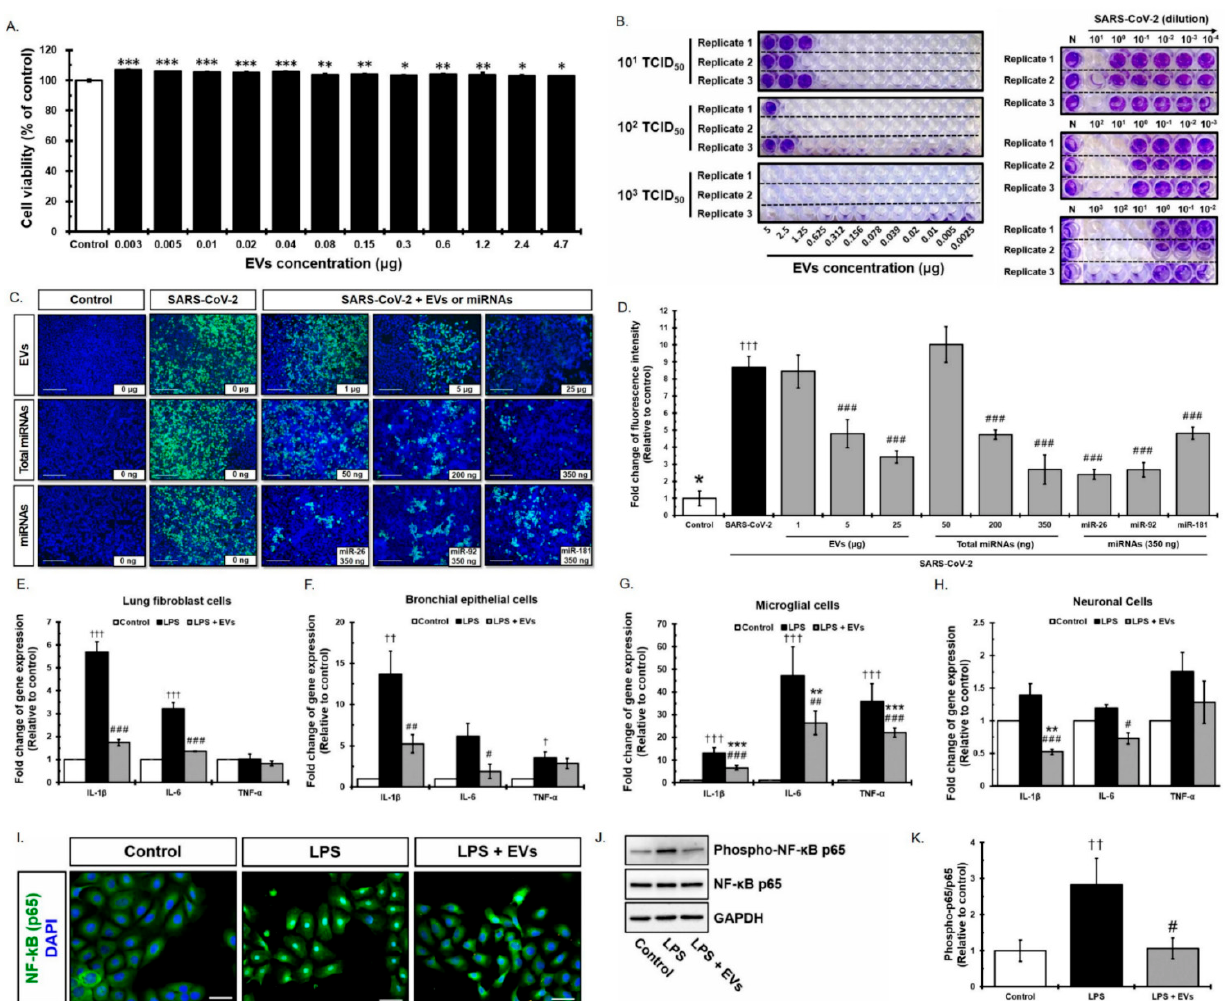
Figure 2. Antiviral effect of placenta-derived EVs against SARS-CoV-2. ( A ) The cytotoxicity of EVs evaluated by using the MTT assay on Vero cells. ( B ) The anti SARS-CoV-2 activity of EVs was tested using an established cell-based screening assay. Vero cells were infected with SARS-CoV-2 virus 10-fold serial dilution: 10 1 TCID 50 /well, 10 2 TCID 50 /well, and 10 3 TCID 50 /well. ( C ) Antiviral effect of placenta-derived EVs, total miRNAs isolated from placenta-derived EVs, and miR-26a-5p, miR-92a-3p, miR-181a-5p against SARS-CoV-2 virus shown in immunofluorescence image. Scale bar: 200 µm. ( D ) Quantification of SARS-CoV-2 infection cells. ( E – H ) Protection effect of EVs on LPS stimulation in lung fibroblast cells (LL24), bronchial epithelial cells (Beas-2B), microglial cells (BV2), and neuronal cells (NSCs). ( I ) Location of NF- κ B p65 after LPS treatment or LPS+EVs treatment. Scale bar: 50 µm. ( J ) Representative expression of NF- κ B p65 and the expression of phospho-p65 after LPS or LPS+EVs treatment measured by Western blot analysis. ( K ) Quantification of the relative density ( J ) of the band of total NF- κ B p65 and phospho-p65 (p-p65). *, **, and *** indicate p < 0.05, <0.01, and <0.001, respectively, compared with the EV treatment group. †, ††, and ††† indicate p < 0.05, <0.01, and <0.001, respectively, compared with the LPS treatment group. #, ##, and ### indicate p < 0.05, <0.01, and <0.001, respectively, compared with between LPS and EVs treated groups.